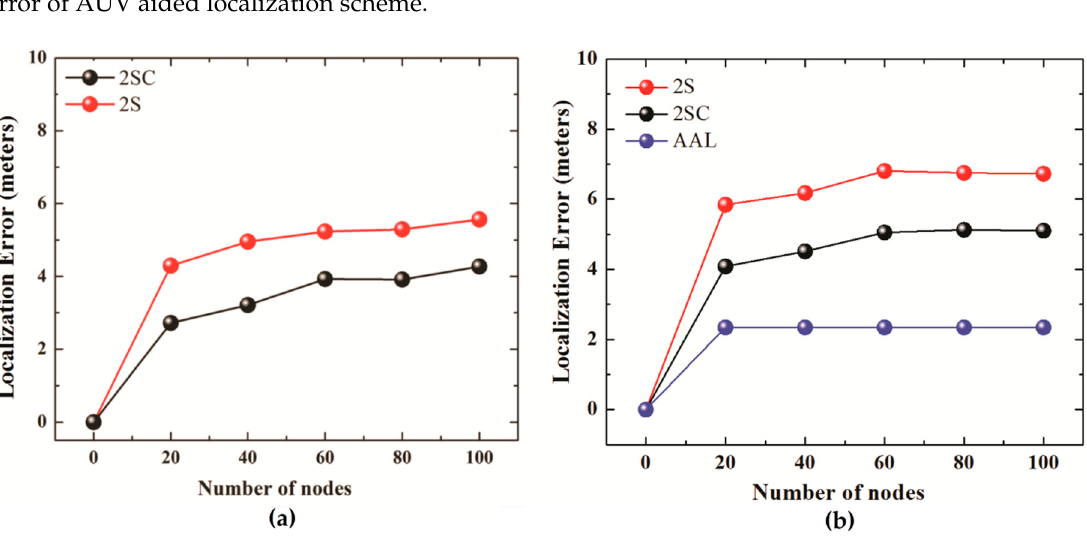
Figure 9. ( a ) Localization error for No. of iterations = 2. ( b ) Localization error for No. of iterations = 3(2S, 2SC), AUV Aided Localization.